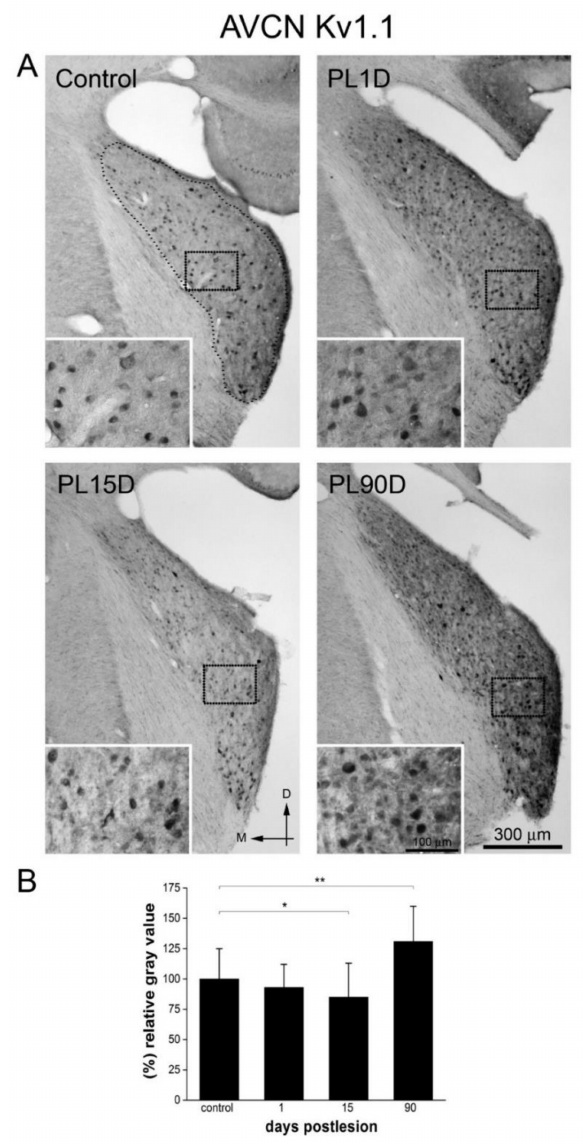
Figure 4. Kv1.1 immunoreactivity levels increase significantly in the AVCN at long-term after cochlear lesion. ( A ) Low-magnification photomicrographs of coronal sections of AVCN. The dotted contour (small dots) in A, outlines an example of the region of interest in the AVCN where thresholding segmentation was carried out for quantification of immunoreactivity. Equivalent regions were selected in all sections sampled. Insets (squares outlined with larger dots in A and B) show high-magnification details of the image. Photographs are representative of five animals. Calibration bars apply to all panels in the figure. ( B ) Quantitative analysis of relative gray value averages at each post-lesion time for Kv1.1 in the AVCN. Whereas a slight but significant decrease in Kv1.1 labeling intensity at 15 days was observed, Kv1.1 intensity increased significantly at 90 days after cochlear lesion. Data are expressed as mean ± S.D. Asterisks show statistically significant di ff erences (* p < 0.05; ** p < 0.01) as determined by one-way ANOVA (F (3,187) = 19.109; p < 0.001), Tukey post-hoc